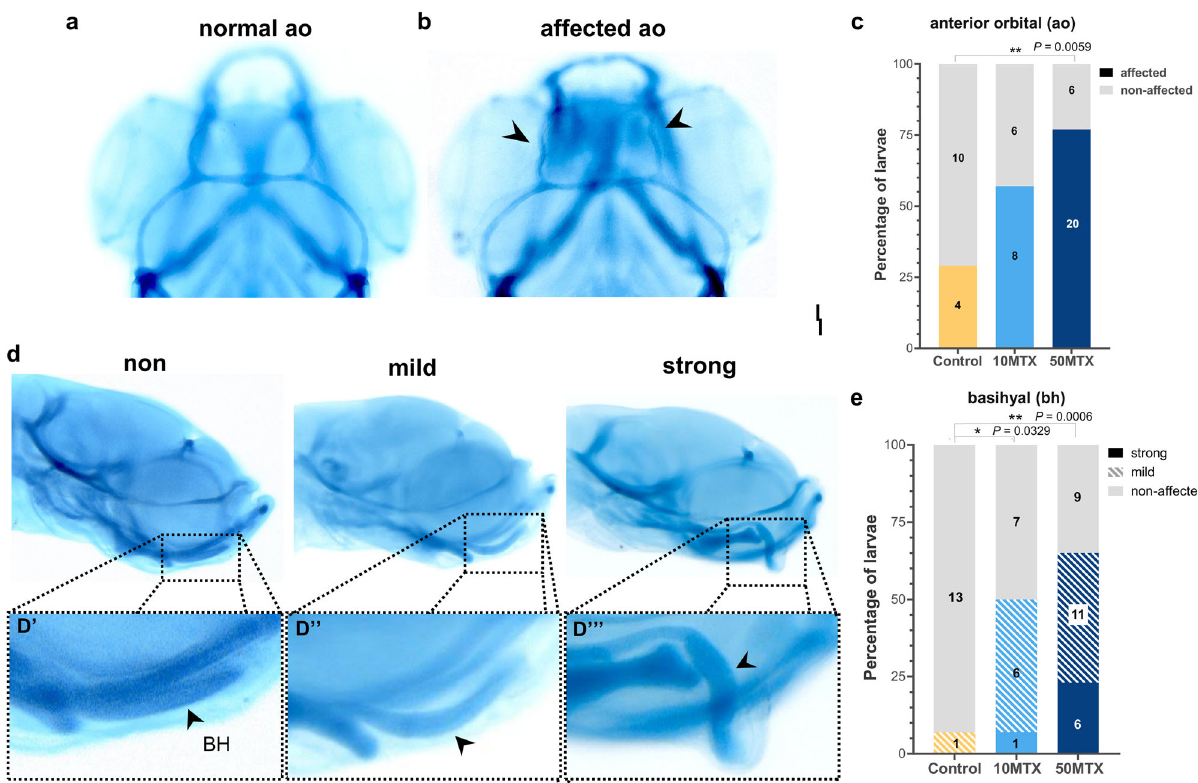
Fig. 2 | Paternal MTX injection produced offspring ’ s cranial cartilages mal- formations.a , b Dorsalviewofnormalandaffectedanteriororbital(ao)showinga meandering shape mostly observed on the offspring from MTX treated males. c Quanti fi cation of the percentage of embryos presenting affected or normal anterior orbital cartilages. Numbers in the graph represent the analyzed embryos. d Lateralviewoflarvaepresentingnormal(trowelshape),mild(bendedshape),and strong (hook shape) deformities of the basihyal cartilage. e Quanti fi cation of the